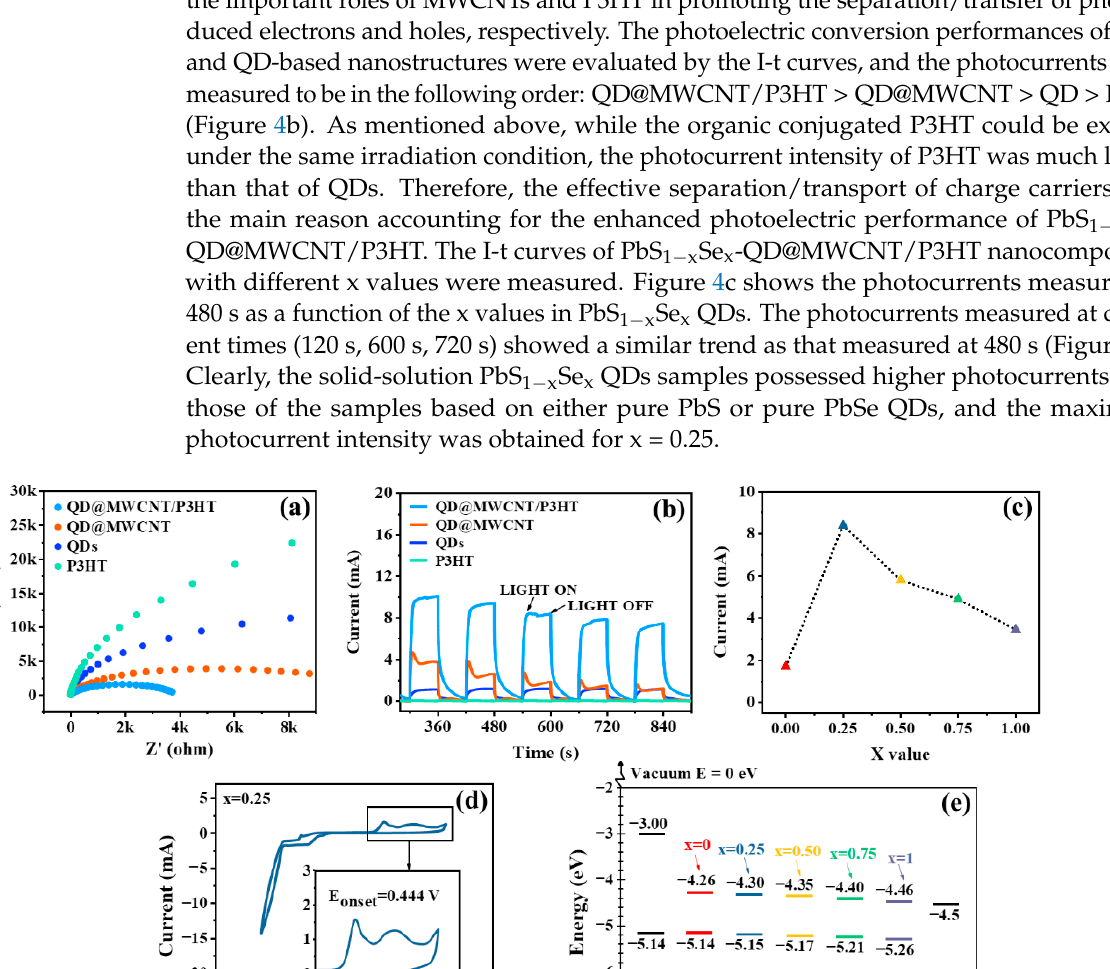
Figure 3. ( a ) TEM and ( b ) HRTEM images of PbS 0.75 Se 0.25 -QD@MWCNT. ( c ) PL spectra of PbS 0.75 Se 0.25 - QDs, PbS 0.75 Se 0.25 -QD@MWCNT and PbS 0.75 Se 0.25 -QD@MWCNT/P3HT. ( d ) Fluorescence decay of